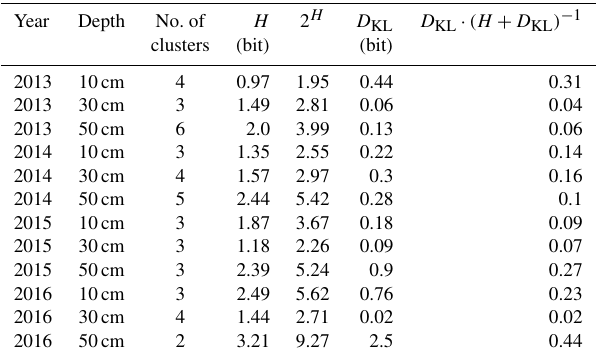
Table 2. Information content and information loss due to com- pression. The information content is given as Shannon entropy H , which is the expectation value of information in information the- ory. 2 H gives the number of distinct states the underlying distribu- tion can resolve. The information loss after compression is given by the Kullback–Leibler divergence D KL between the compressed and uncompressed series of dispersion functions. The last column relates D KL to H